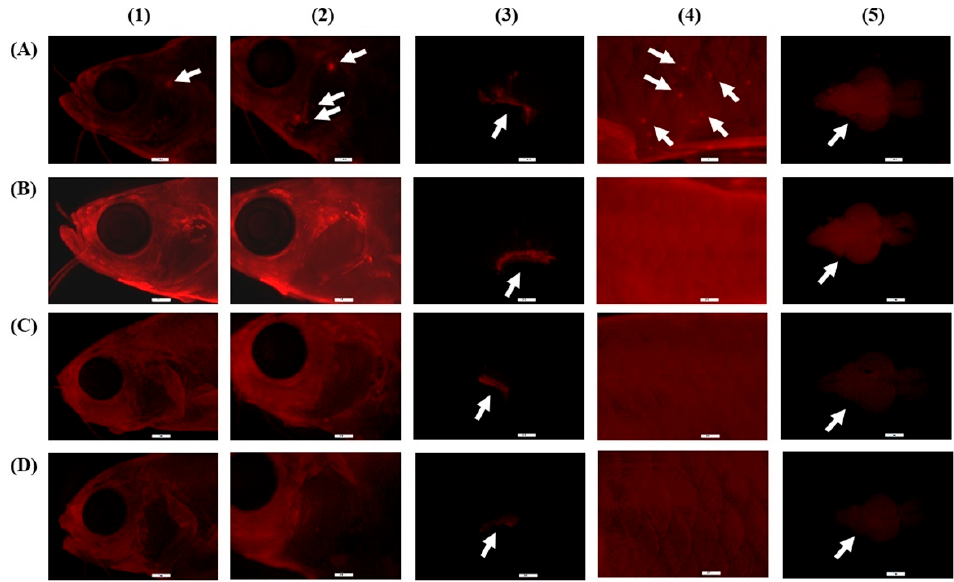
Figure 2. Fluorescence microscopy images of CONR-EtOH ( A ), CONR-NE ( B ), CONR-SMEDDS ( C ), and CONR-SNEDDS ( D ) accumulated in external and internal organs of transparent zebrafish: head (1), gill (2), gill filament (3), skin (4), and brain (5). These illustrations are demonstrated for qualitative determination.